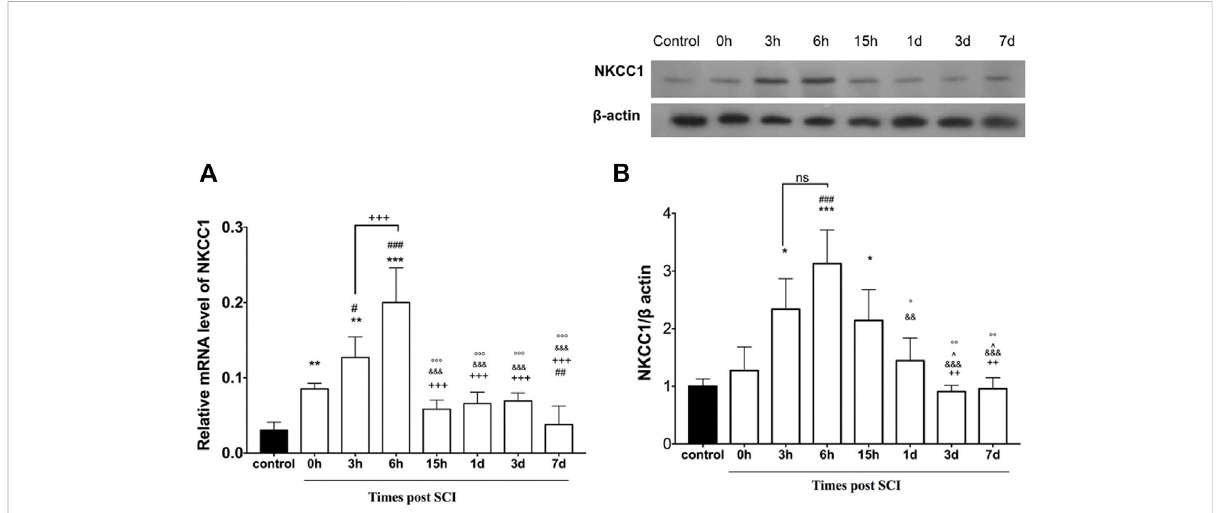
FIGURE 2 Altered expression of NKCC1 in the lesion center following spinal cord injury. (A) Time course-dependent change of mRNA NKCC1. (B) Protein expression of NKCC1 at the injured spinal cord (epicenter). * p ≤ 0.05, ** p ≤ 0.01, *** p ≤ 0.001 vs. control group; # p ≤ 0.05, ### ≤ 0.001 vs.0